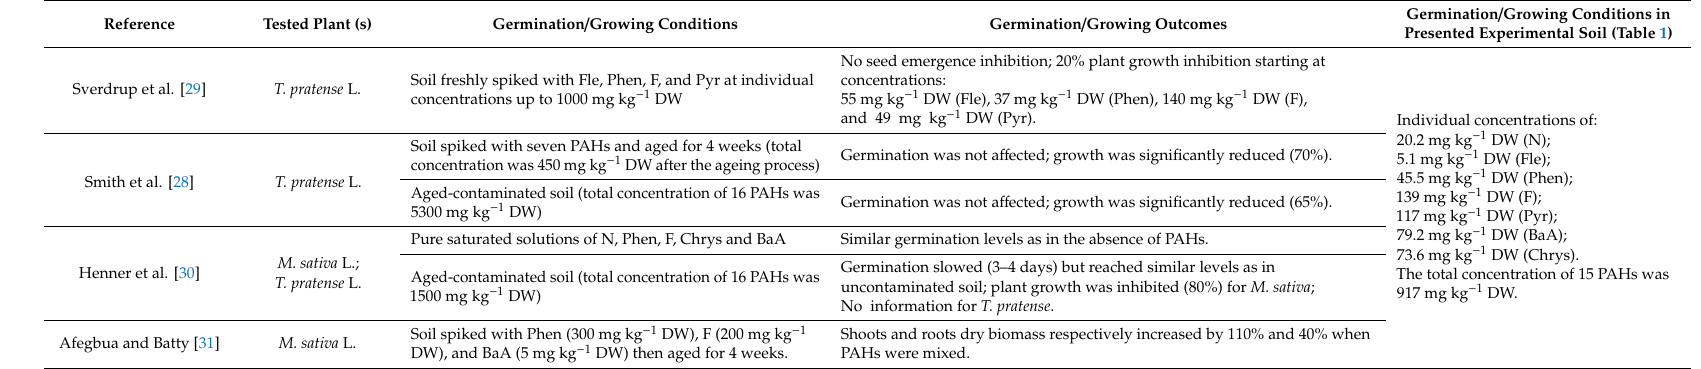
Table 4. Comparison of germination and growing conditions and outcomes between a few published references and the presented experimental soil, for Medicago sativa L. and Trifolium pratense L.